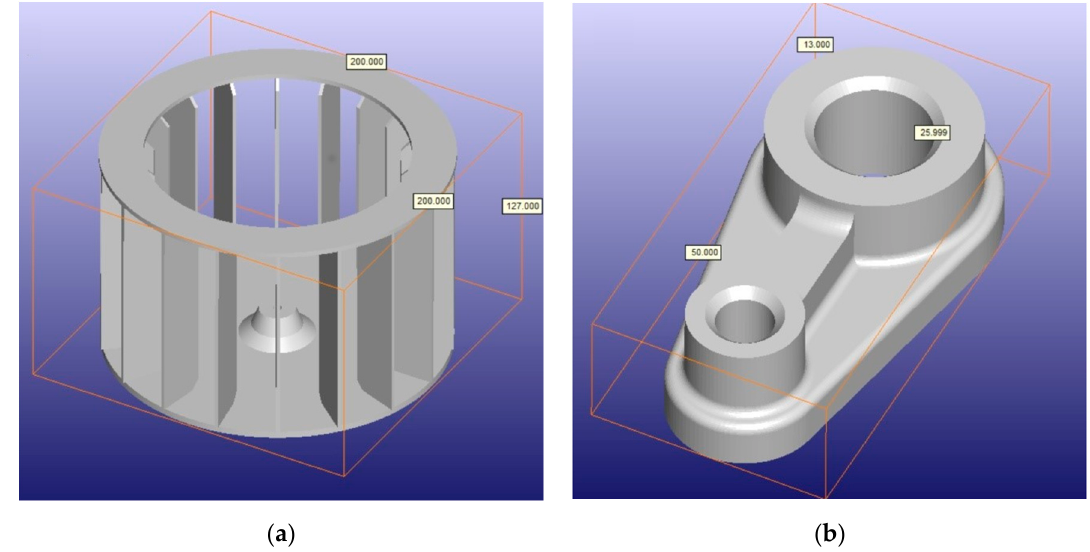
Figure 8. 3D-STL models of the test elements: ( a ) rotor; ( b ) bracket.